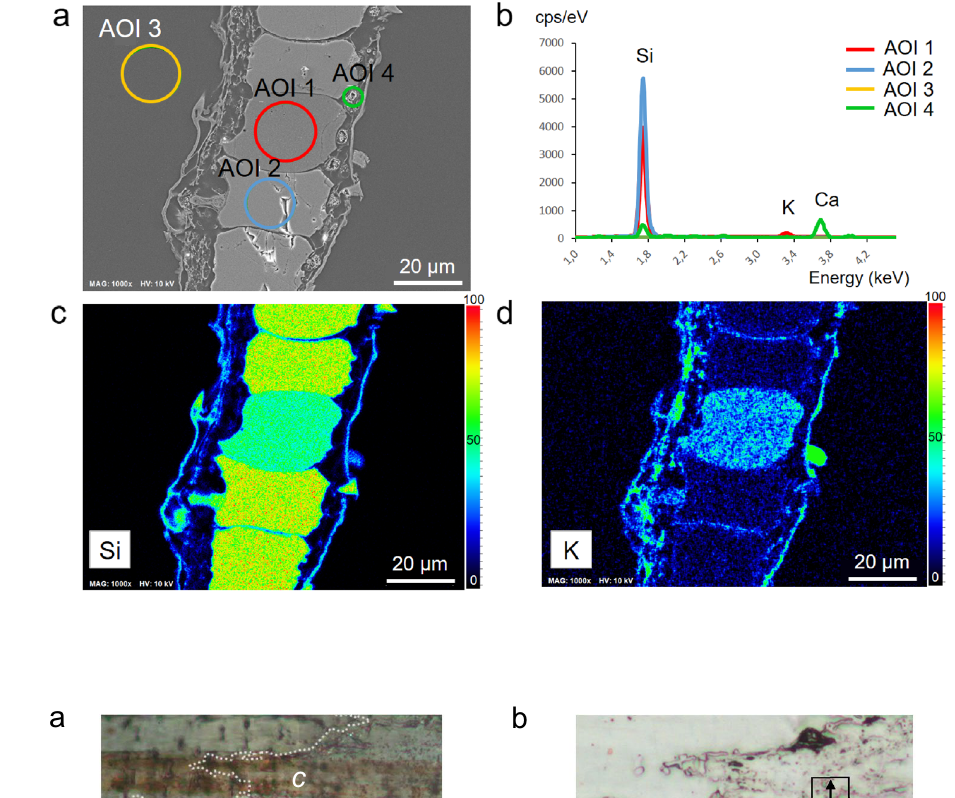
Fig. 5 Two costal and inter- costal zones (Primavera-16). a Light microscope picture with the dotted line demarcating margins of areas lost during sample leveling before SEM; b SEM image with demarcated location of the EDS transect crossing a bulliform cell; c Intensities of Si, K and Ca